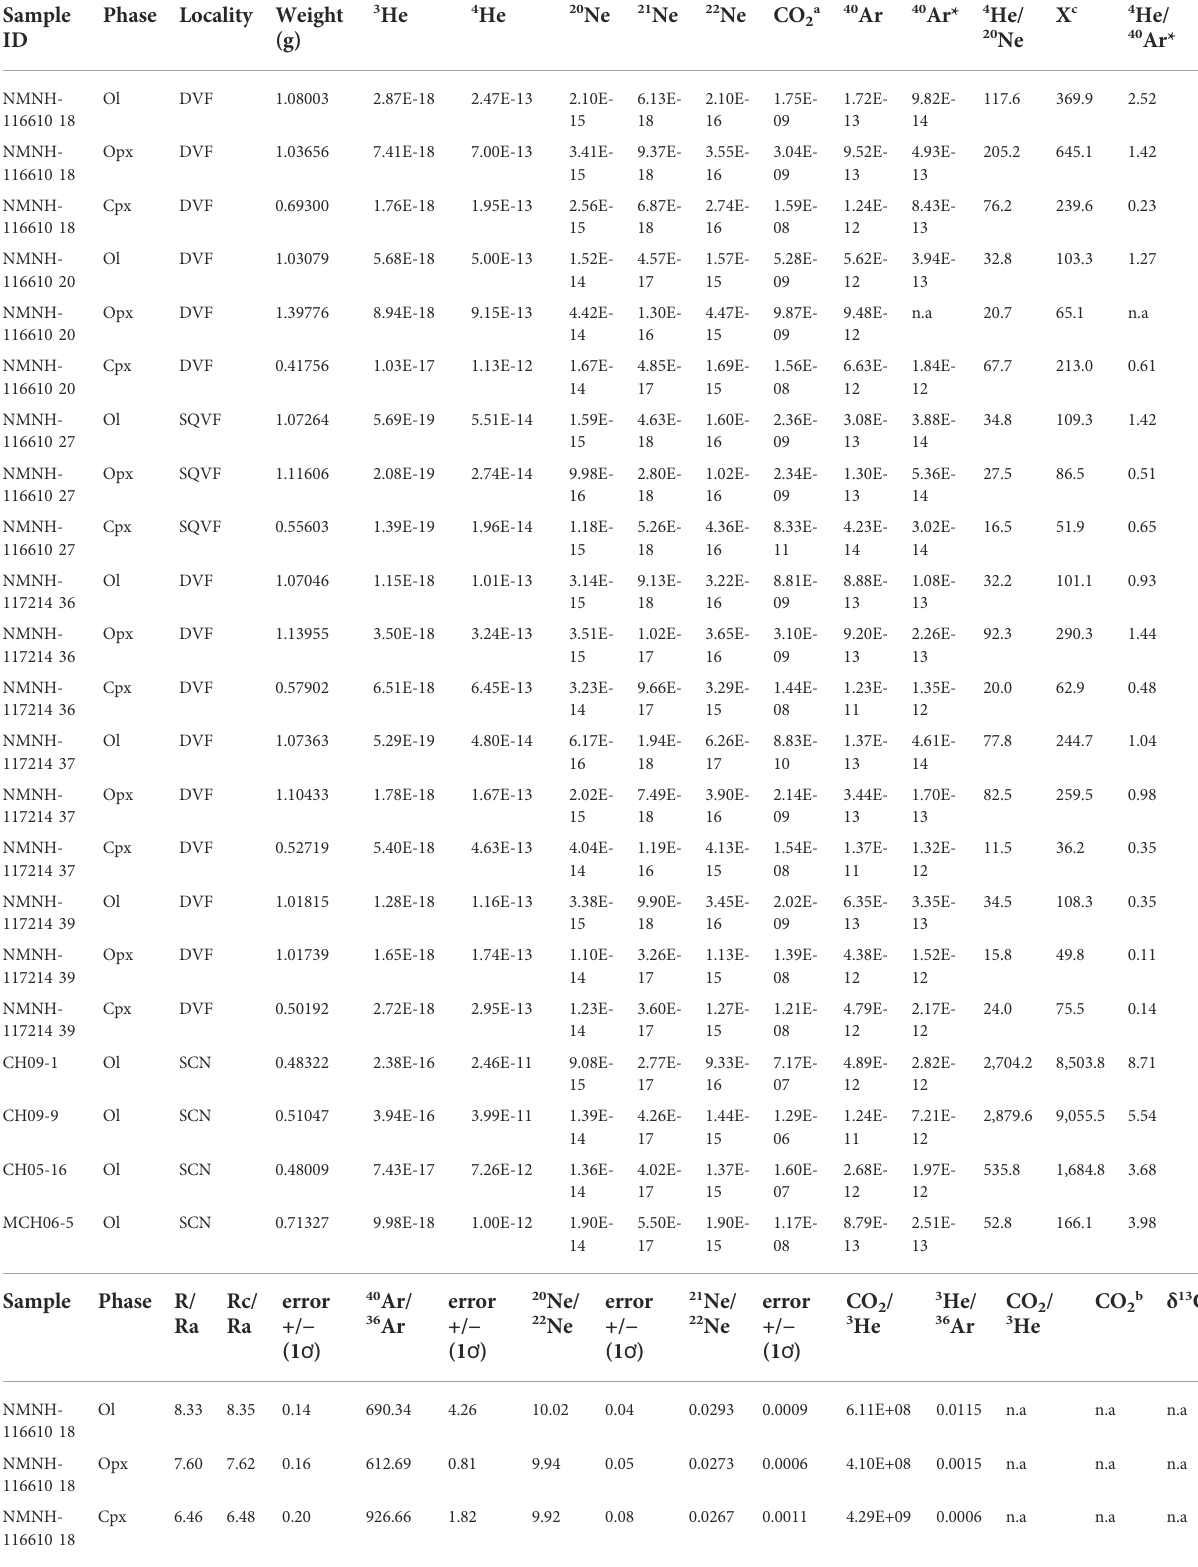
TABLE 2 Fluid inclusion compositions from DVF — SQVF mantle xenoliths and SCN olivine-related lavas. Concentrations of noble gases isotopes and CO 2 are reported in